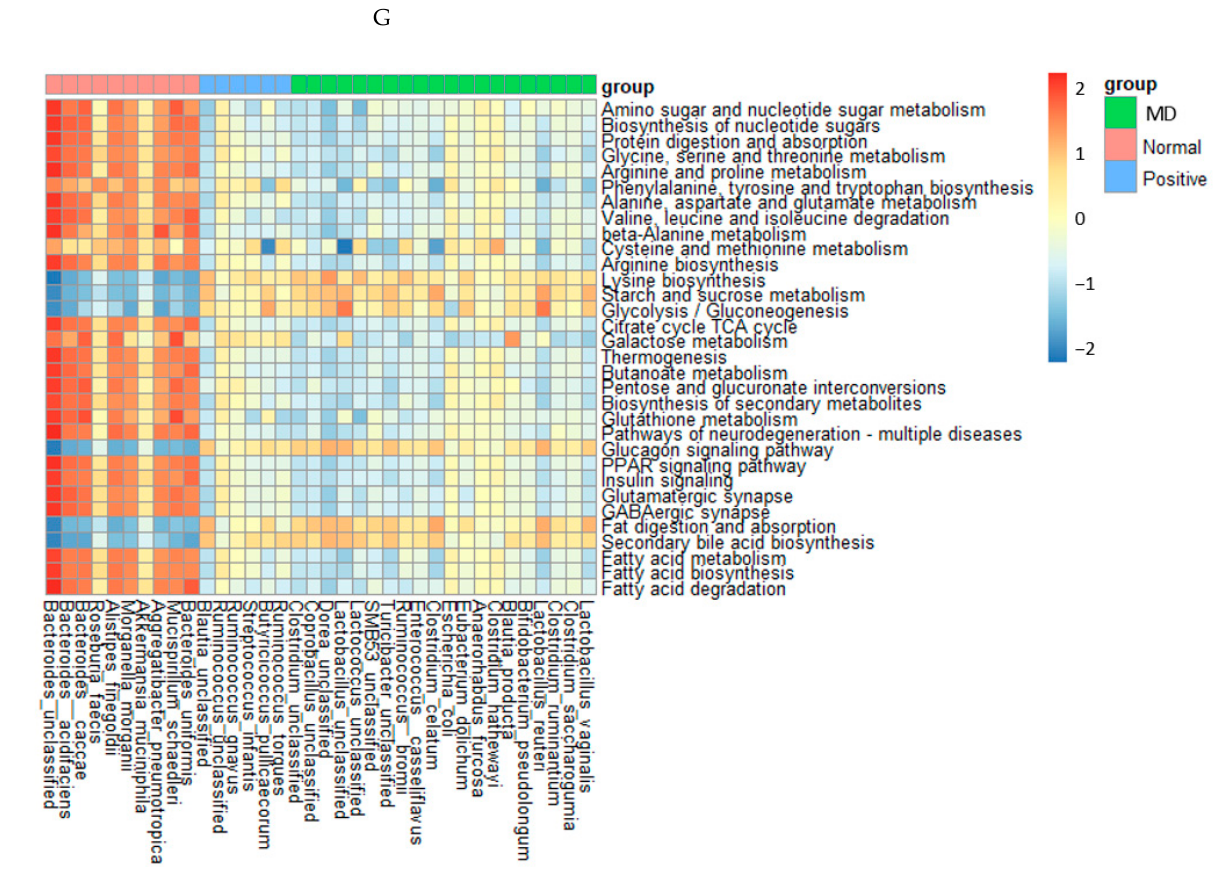
Figure 6. Characteristics of the fecal bacteria in the scopolamine-injected rats. ( A ) Chao1 index. ( B ) Shannon index. ( C ) β -diversity. Color of the circles represented the same as group names. ( D ) Relative abundance of the bacteria at the genus level. ( E ) LDA scores of bacteria at the species level. ( F ) Metagenome functions of the primary bacteria. (G) Metagenome functions of the primary bacteria in animal samples. a,b,c Different letters on the bar indicated significant differences among the groups at p < 0.05 in each figure.